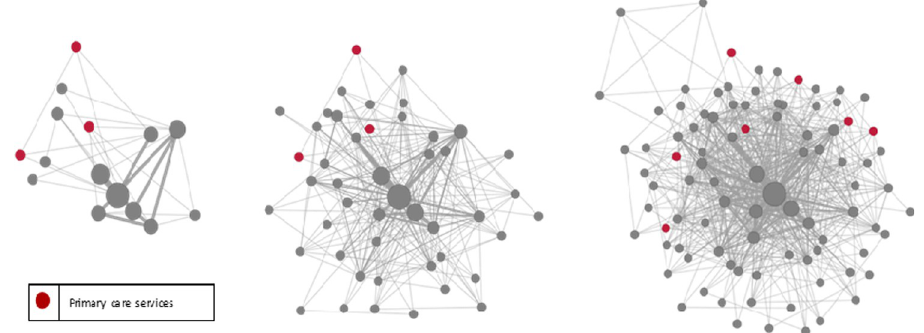
Fig 3. Research collaboration by type of organisation: Primary care or